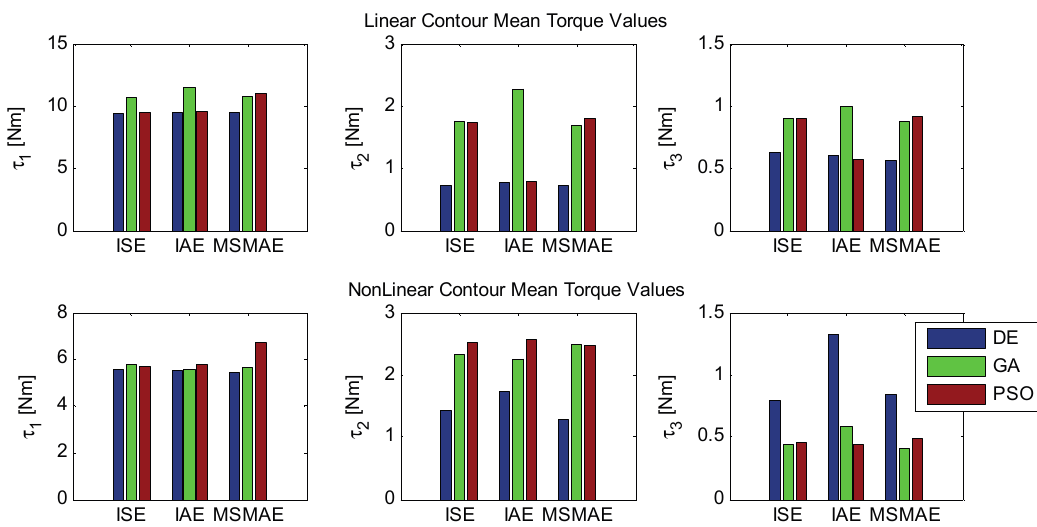
Figure 7. Mean required torques for both